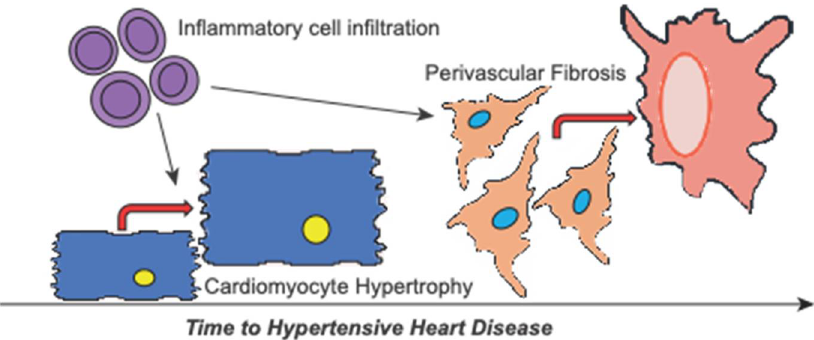
Figure 5. Schematic of cardiac remodelling involved in hypertensive heart disease progression. Hypertension causes cardiac remodelling with hypertensive heart disease marked by global cardiac hypertrophy and notable fibrosis. Our data indicate that remodelling is primed by increased pro- inflammatory signalling and inflammatory cell infiltration. Subsequently, inflammation encourages further hypertrophy of the cardiomyocytes contributing to the early remodelling phase. Over time, this promotes the progression of hypertensive heart disease towards failure resulting from increasing perivascular fibrosis.